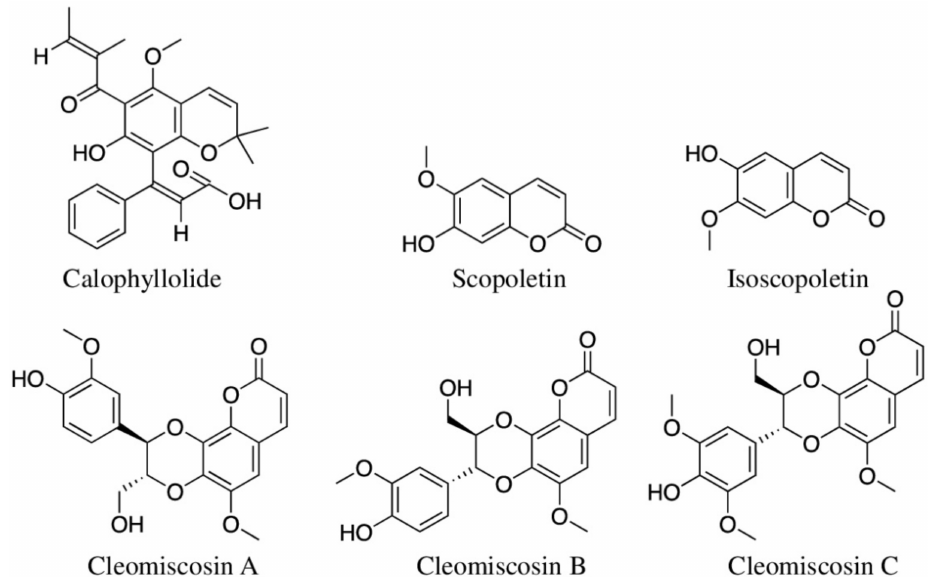
Figure 8. Chemical structure of anti-inflammatory